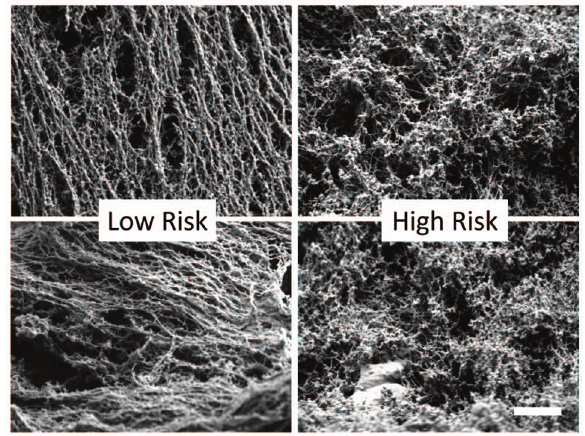
Figure 4. (A) Diagram of bead permeability assay. (B) Bead permeability assay results. High risk cervical mucus samples displayed significantly more permeability to the biotin labeled polystyrene beads compared to low risk controls (5.6 beads/field ( + / 2 2.6) vs. 2.2 beads/field ( + / 2 1.2), p=0.006).